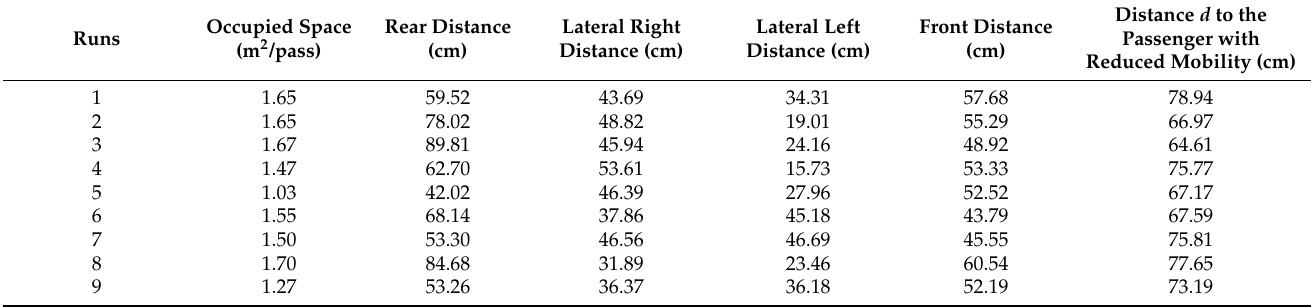
Table 1. Average space occupied by a wheelchair passenger waiting to board the